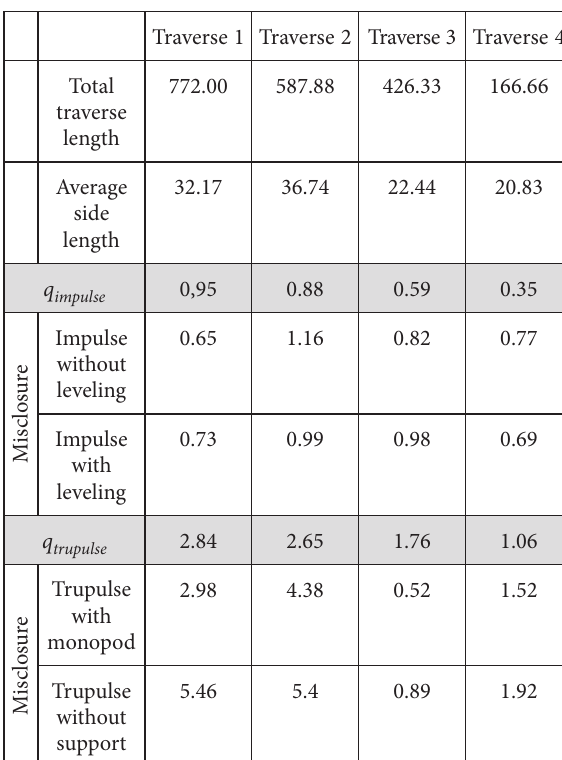
Table 4. Basic characteristics of experimental compass traverses, predicted positional shifts and obtained positional misclosures according to used equipment and measurement variant